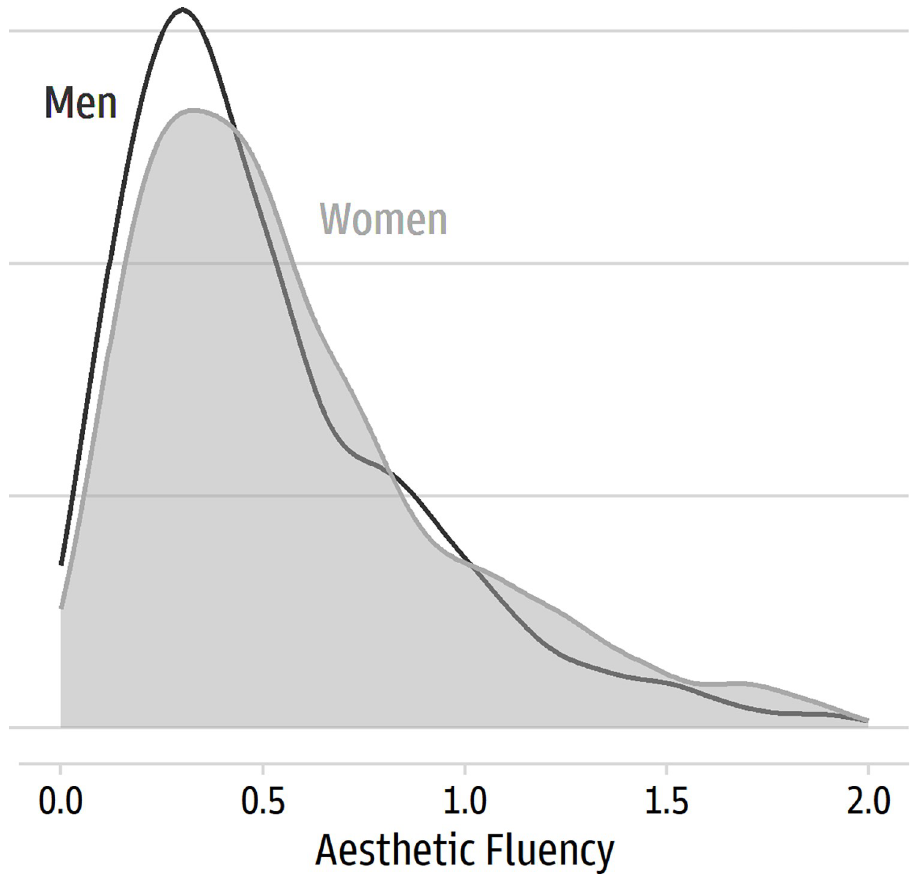
Fig 6. Distribution of average aesthetic fluency scores for women and men.